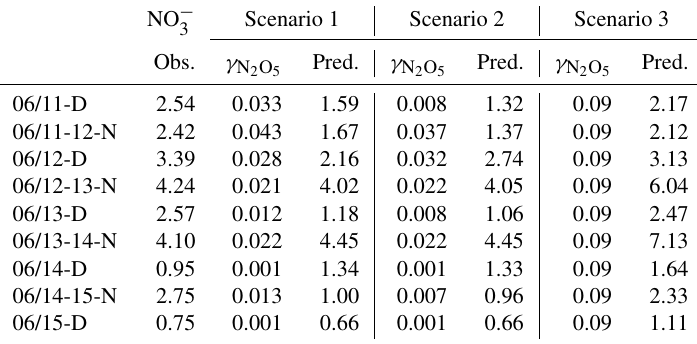
Table 3. Observed day (D) and night (N) NO − trations (Pred.) using the parameterizations of γ N upper-limit value derived by Zhou et al. (2018; Scenario 3) from 11 to 15 June